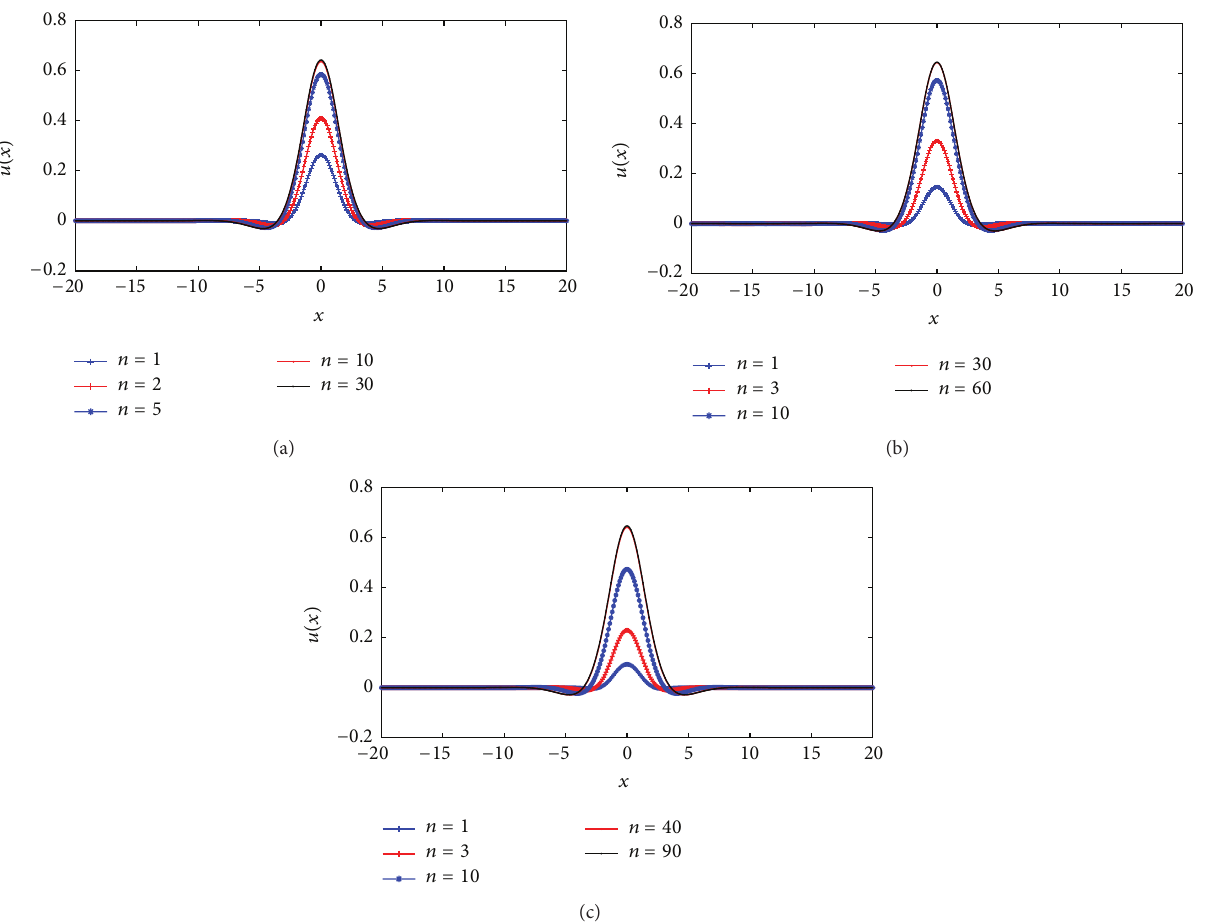
Figure 9: Convergence behavior of the applied iterative method 𝐸 = 𝐼 = 𝑘 = 1 , 𝛾 = 0.2 : (a) 𝑘 𝑝 = 3 , (b) 𝑘 𝑝 = 6 , and (c) 𝑘 𝑝 = 10 .